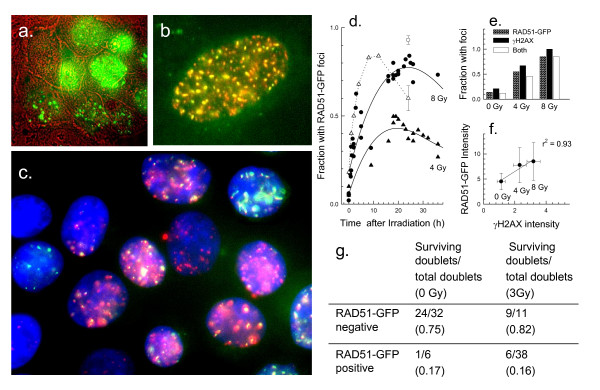
RAD51-GFP as a live cell marker. Panel a: RAD51-GFP foci in live SiHa cells stably transfected with RAD51-GFP are shown 24 hours after exposure to 8 Gy. The phase contrast image is indicated by red outlines. Panel b: Co-localization between RAD51-GFP and anti-RAD51 antibody staining (red) in an untreated SiHa cell. Panel c: Co-localization between RAD51-GFP (green) and γH2AX antibody staining (red) in SiHa cells 24 hours after exposure to 8 Gy. Panel d: Analysis of the fraction of SiHa-RAD51-GFP cells that develop foci as a function of time after exposure to 4 Gy or 8 Gy. Results from several experiments are pooled. The dotted line and open circles show the development of RAD51 antibody-labelled foci after exposure to 4 Gy. The single open triangle shows the fraction of RAD51 antibody-labeled cells 24 hours after 8 Gy. Panel e: The fraction of cells that exhibit RAD51-GFP foci or γH2AX foci 24 hours after exposure to radiation, measured microscopically. Panel f: SiHa-RAD51-GFP cells expressing high levels of RAD51-GFP after 24 hours after irradiation were sorted on the basis of GFP, fixed and stained for γH2AX. The average intensity of the populations was measured using flow cytometry. The mean and standard error for 3 sorted populations is shown. Panel g: Clonogenicity of SiHa-RAD51-GFP cells after 0 or 3 Gy exposure. Cells in 8-well dishes were irradiated and 24 hours later, wells containing one or two doublets were scored for the presence or absence of γH2AX foci (daughter cell pairs show the same foci patterns). Dishes were returned to the incubator for 2 weeks to form colonies. The fraction of doublets with foci that survived treatment or the fraction lacking foci that survived treatment was calculated.